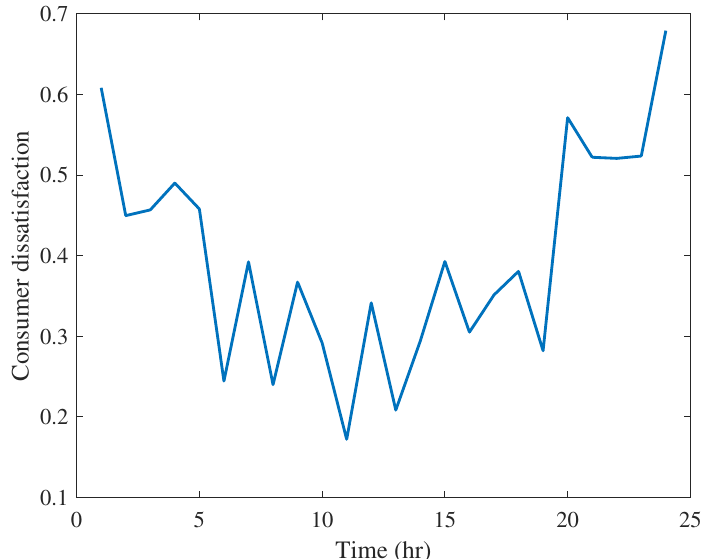
Figure 15. End − user dissatisfaction index with DR. Table 4. Optimal percentage of DR considering user comfort. Time